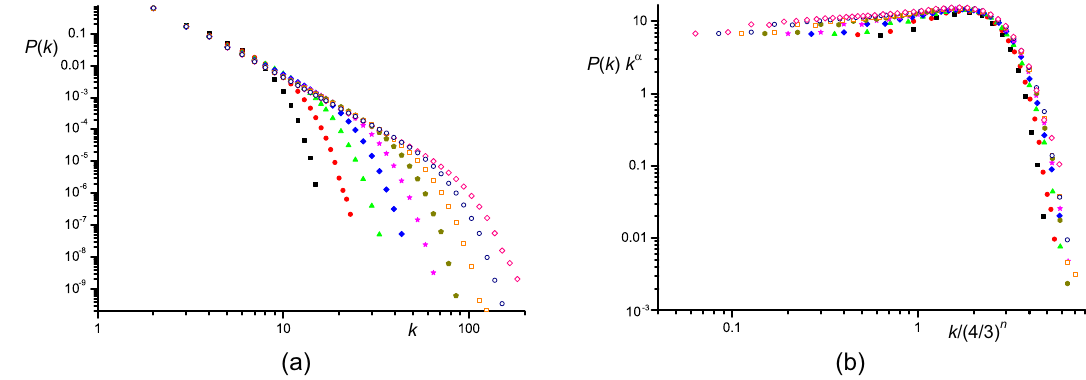
Figure 5. ( a ) Degree distributions of the hexagon-based networks of generations 4–12 as indicated. The results shown are obtained after averaging over 2 × 10 5 realizations and logarithmic binning with step 1.1. ( b ) Same distributions but rescaled as the axes